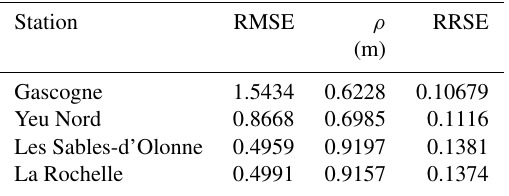
Table 2. Goodness of fit for water level and wave measurements compared with the results of